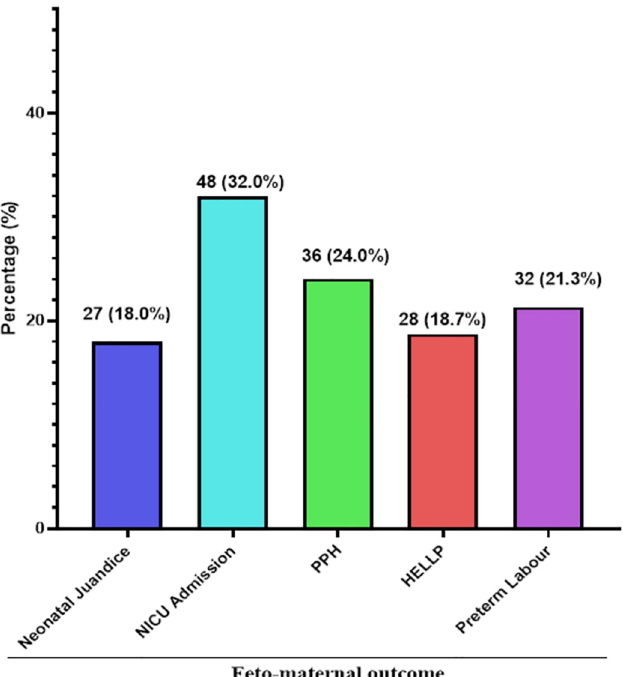
Fig 2. Foetal and maternal outcomes of study participants. PPH: Post-partum haemorrhage, HELLP: Hemolysis, Elevated Liver enzymes and Low Platelets. Some participants had multiple foeto-maternal outcome.